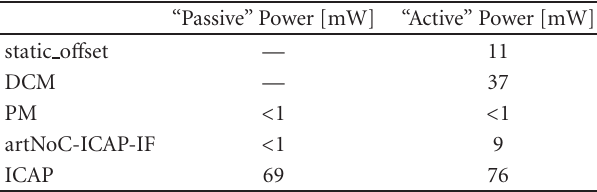
Table 3: Component power consumption.